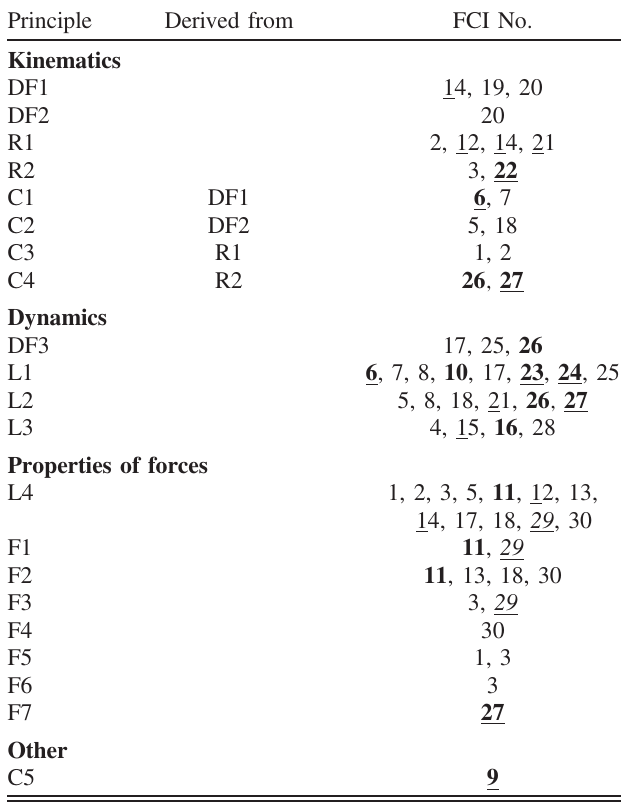
TABLE VI. Principles included in the optimal model of the FCI, model 3. Items in bold are the blocked items removed from the analysis. Underlined items are items identified as unfair to men or women by Traxler et al. [16] (Item 29 was identified as fair but